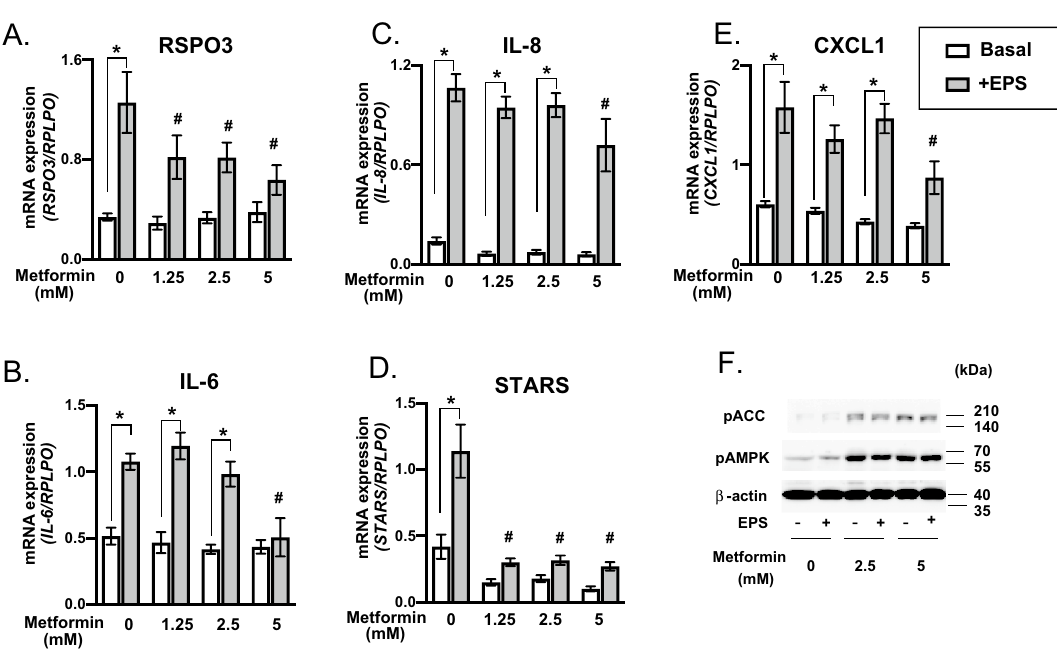
Figure 6. Effects of metformin on EPS-inducible upregulation of human R-spondin 3 (RSPO3) and other factors. EPS (1 Hz, 4-ms, 20 V/25 mm) was applied to the differentiated myotubes in the presence or absence of the indicated concentrations of metformin. Total RNA samples were prepared and subjected to RT-PCR analysis to evaluate mRNA levels for RSPO3 ( A ), IL-6 ( B ), IL-8 ( C ), CXCL1( D ), and striated muscle activator of Rho signaling (STARS) ( E ). Data normalized using RPLP0 transcript were averaged over 3 independent experiments. Multi factor ANOVA with Tukey’s multiple comparison test was used for statistical analyses; the effect of EPS is denoted as * P < 0.05; the effect of metformin is denoted as # < 0.05. ( F ) Whole cell lysates of the differentiated human myotubes (day8) with and without a total of 24 h of EPS (1 Hz, 4-ms, 20 V/25 mm) in the presence of metformin (0, 2.5, 5 mM) were subjected to Western blot analysis using anti-phospho-acetyl-CoA carboxylase (pACC), anti-phospho-AMP-activated kinase (pAMPK), and anti-β-actin antibodies. Three independent experiments were performed; representative results are